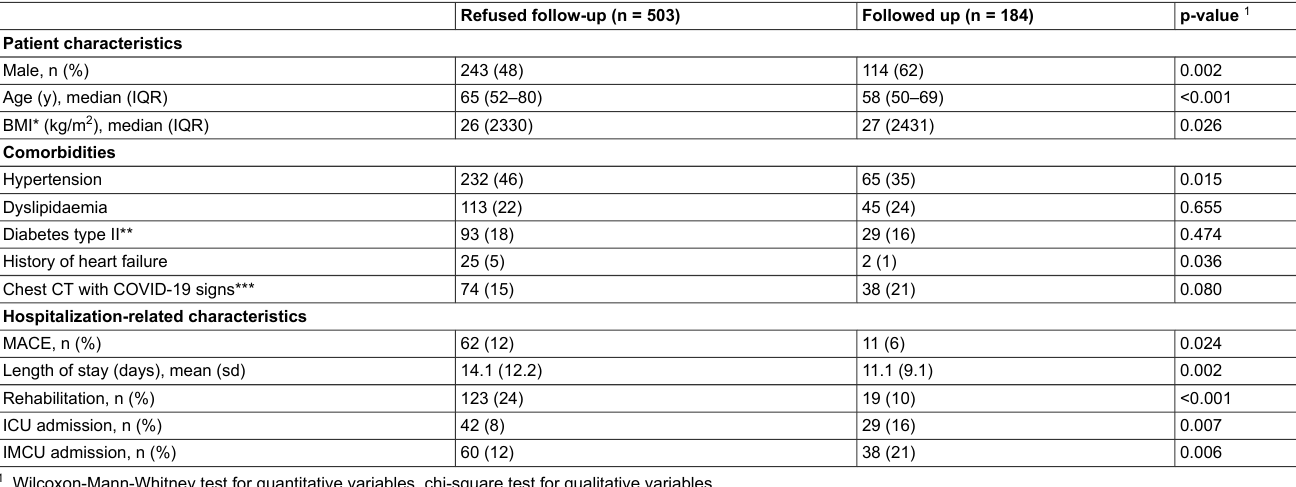
Table 1: Patient and hospital stay